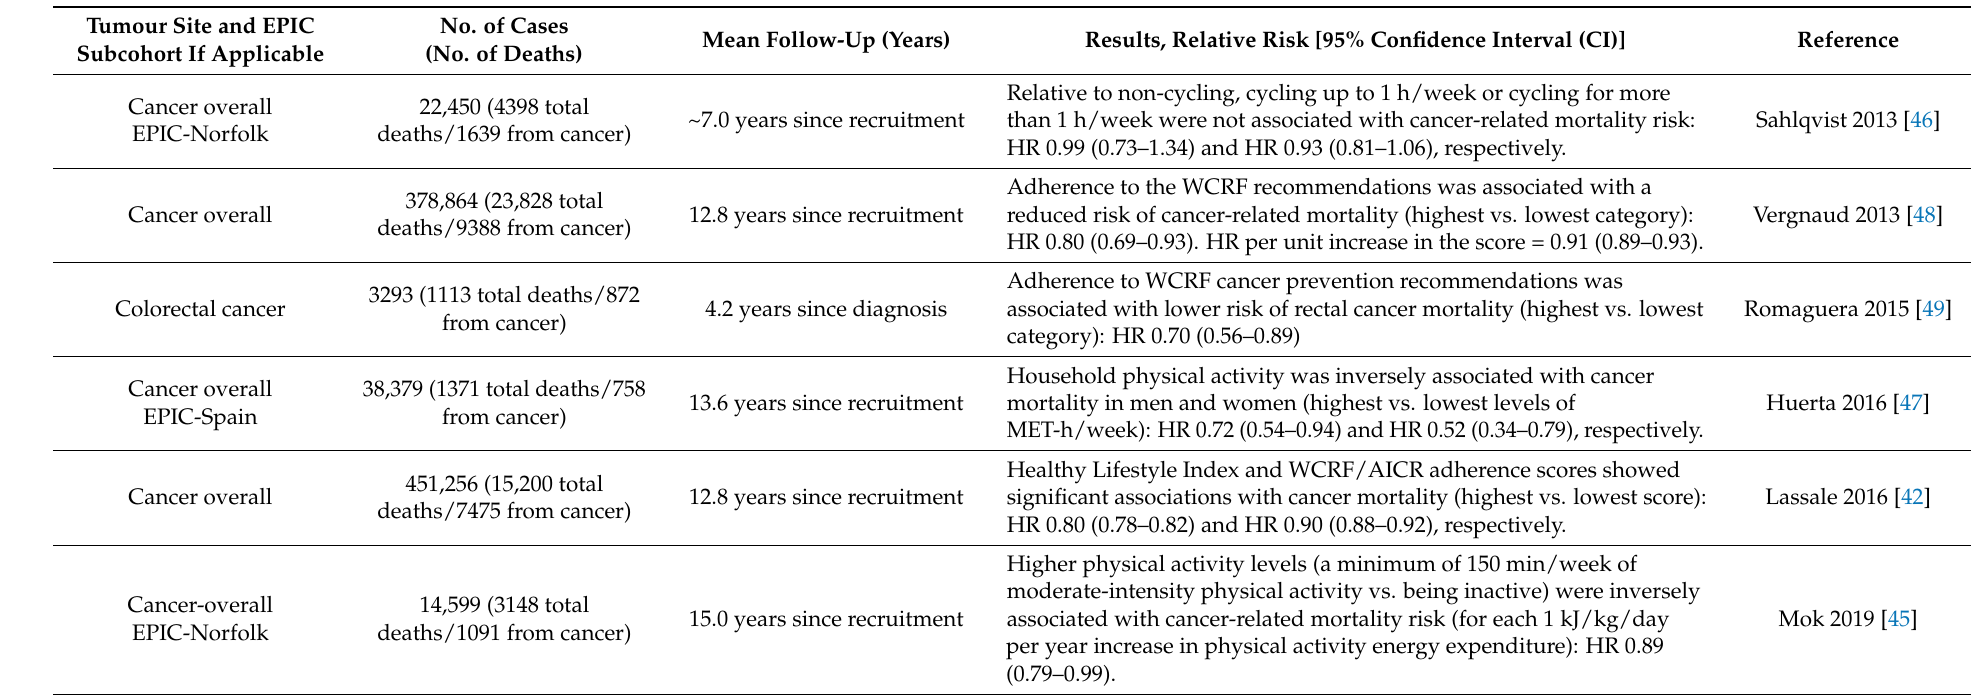
Table 2. Other lifestyle exposures investigated as potential protective factors for cancer mortality in the EPIC